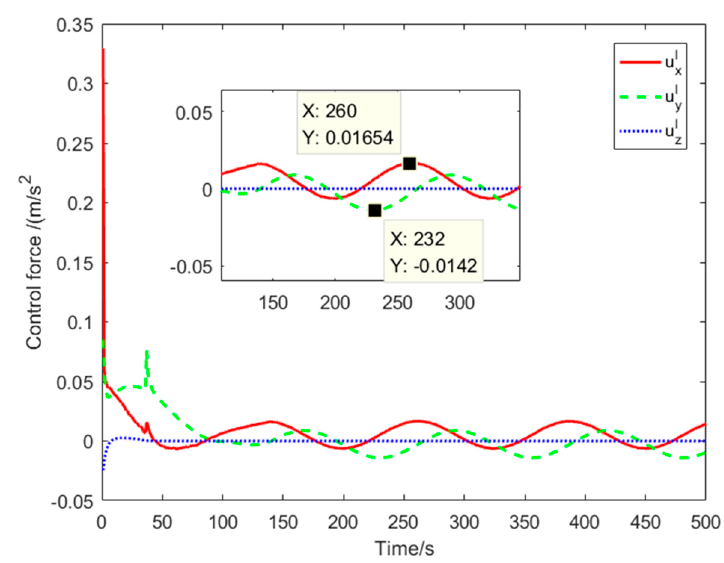
Figure 11. Time response of control force u l .